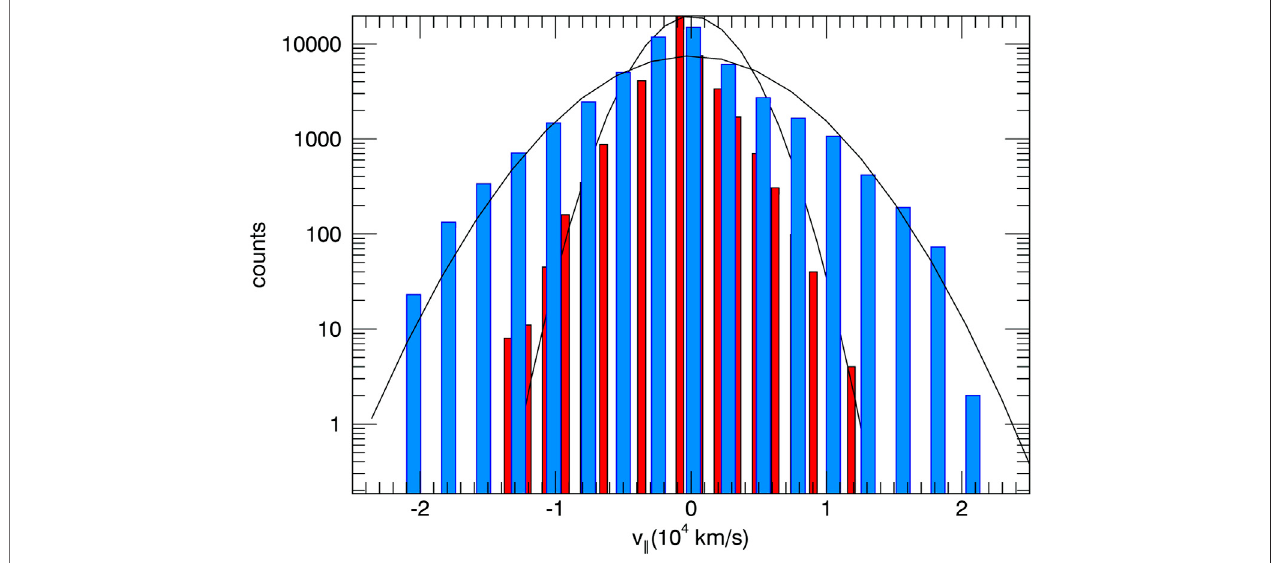
FIGURE 15 | The parallel velocity distribution from electron test particle simulations. Red is the initial 20 eV distribution. Blue is the ∼ 120 eV ensemble-averaged